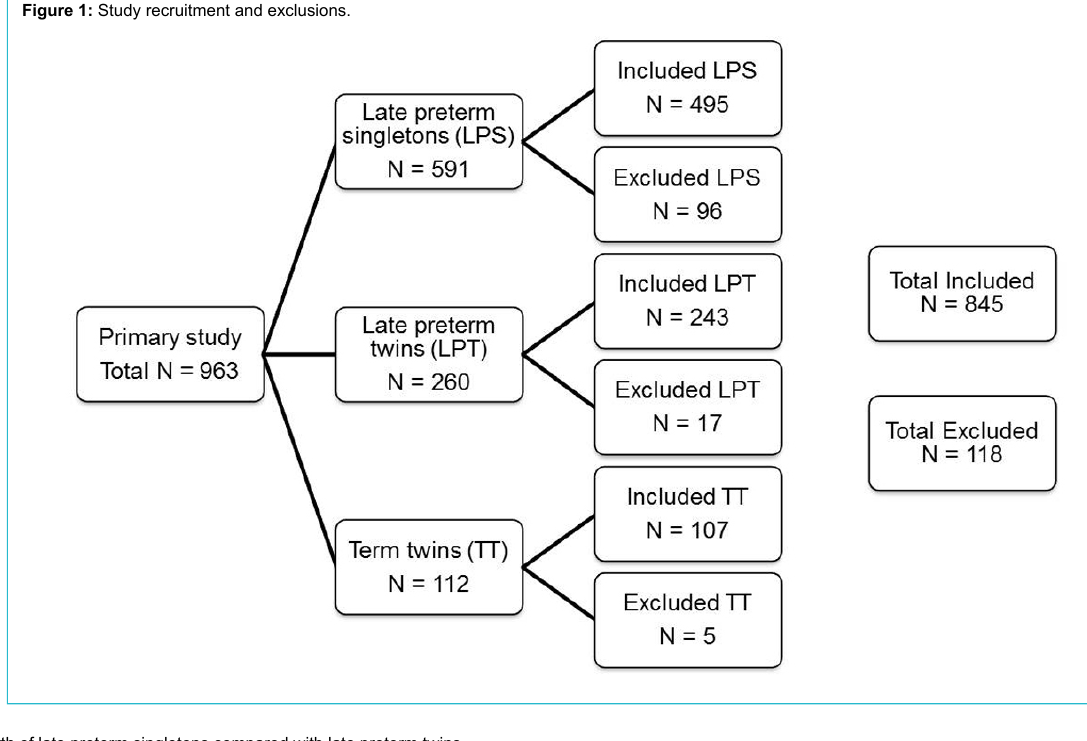
Table 1: Characteristics at birth of late preterm singletons compared with late preterm twins.